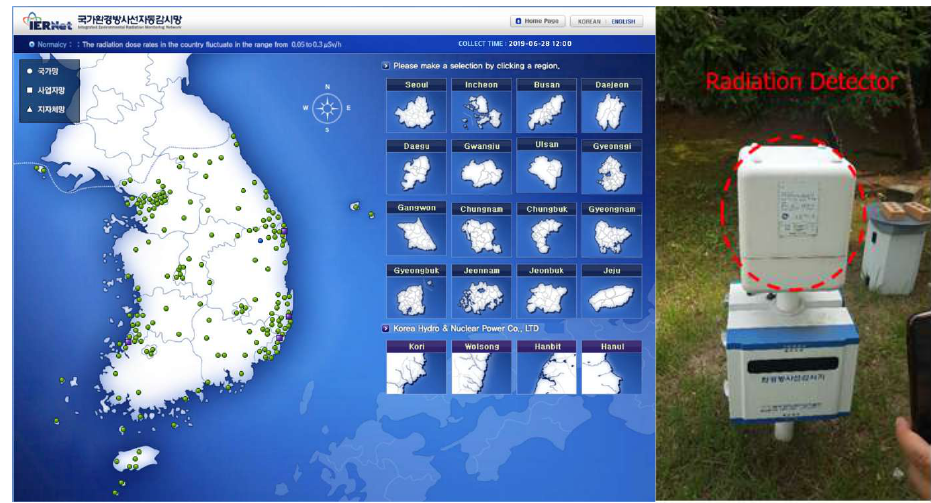
Figure 10. IERNet for environmental radiation